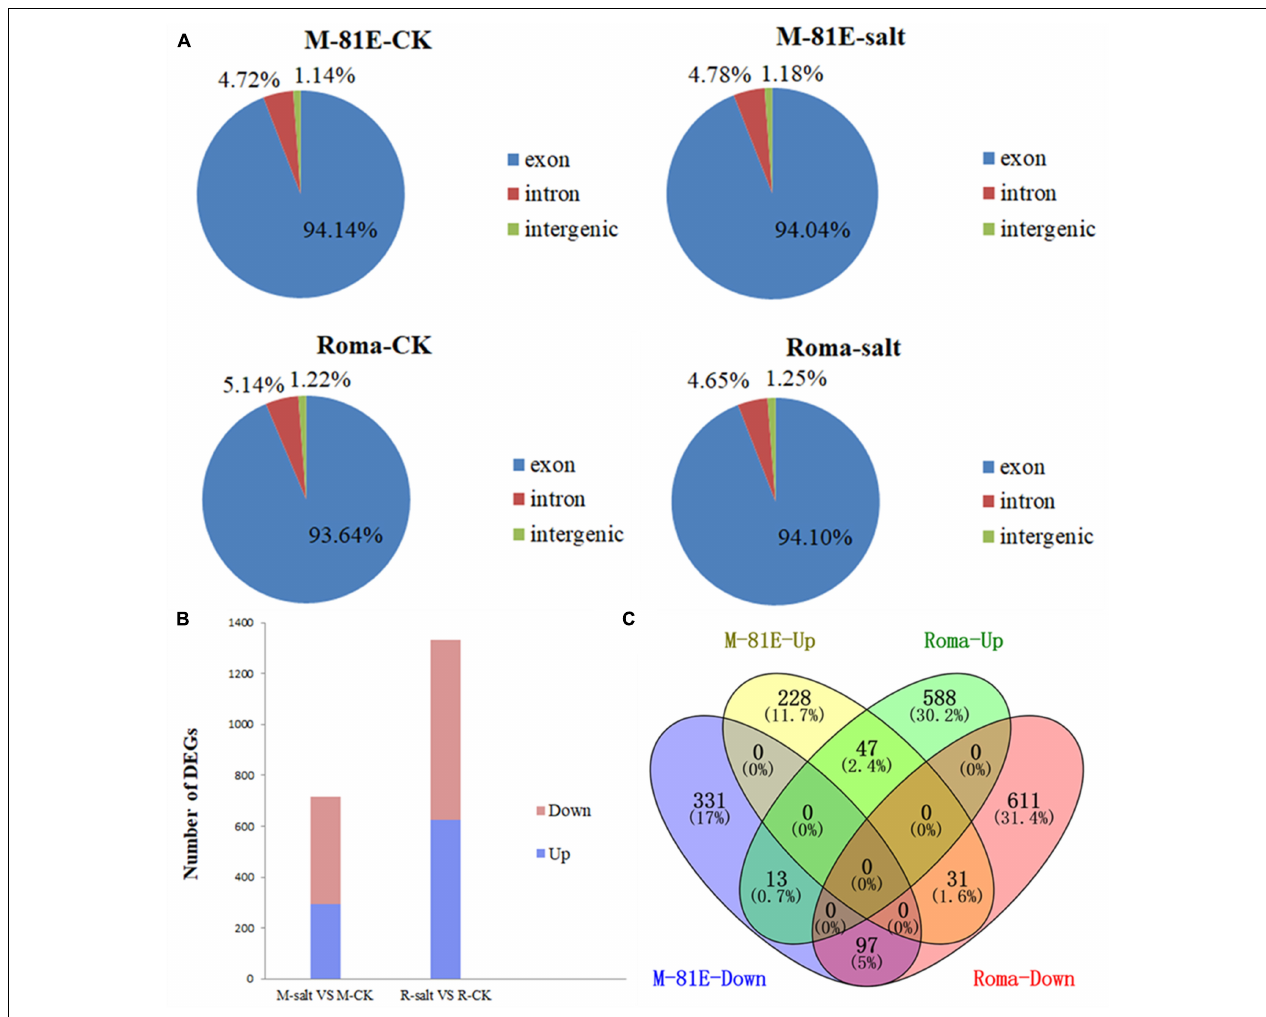
FIGURE 1 | Unique reads mapped to various genomic regions, and identification and characterization of DEGs in M-81E and Roma between salt stress and control samples. (A) Unique reads mapped to various genomic regions. (B) Numbers of DEGs. (C) Venn diagram showing DEGs typically expressed in M-81E and Roma